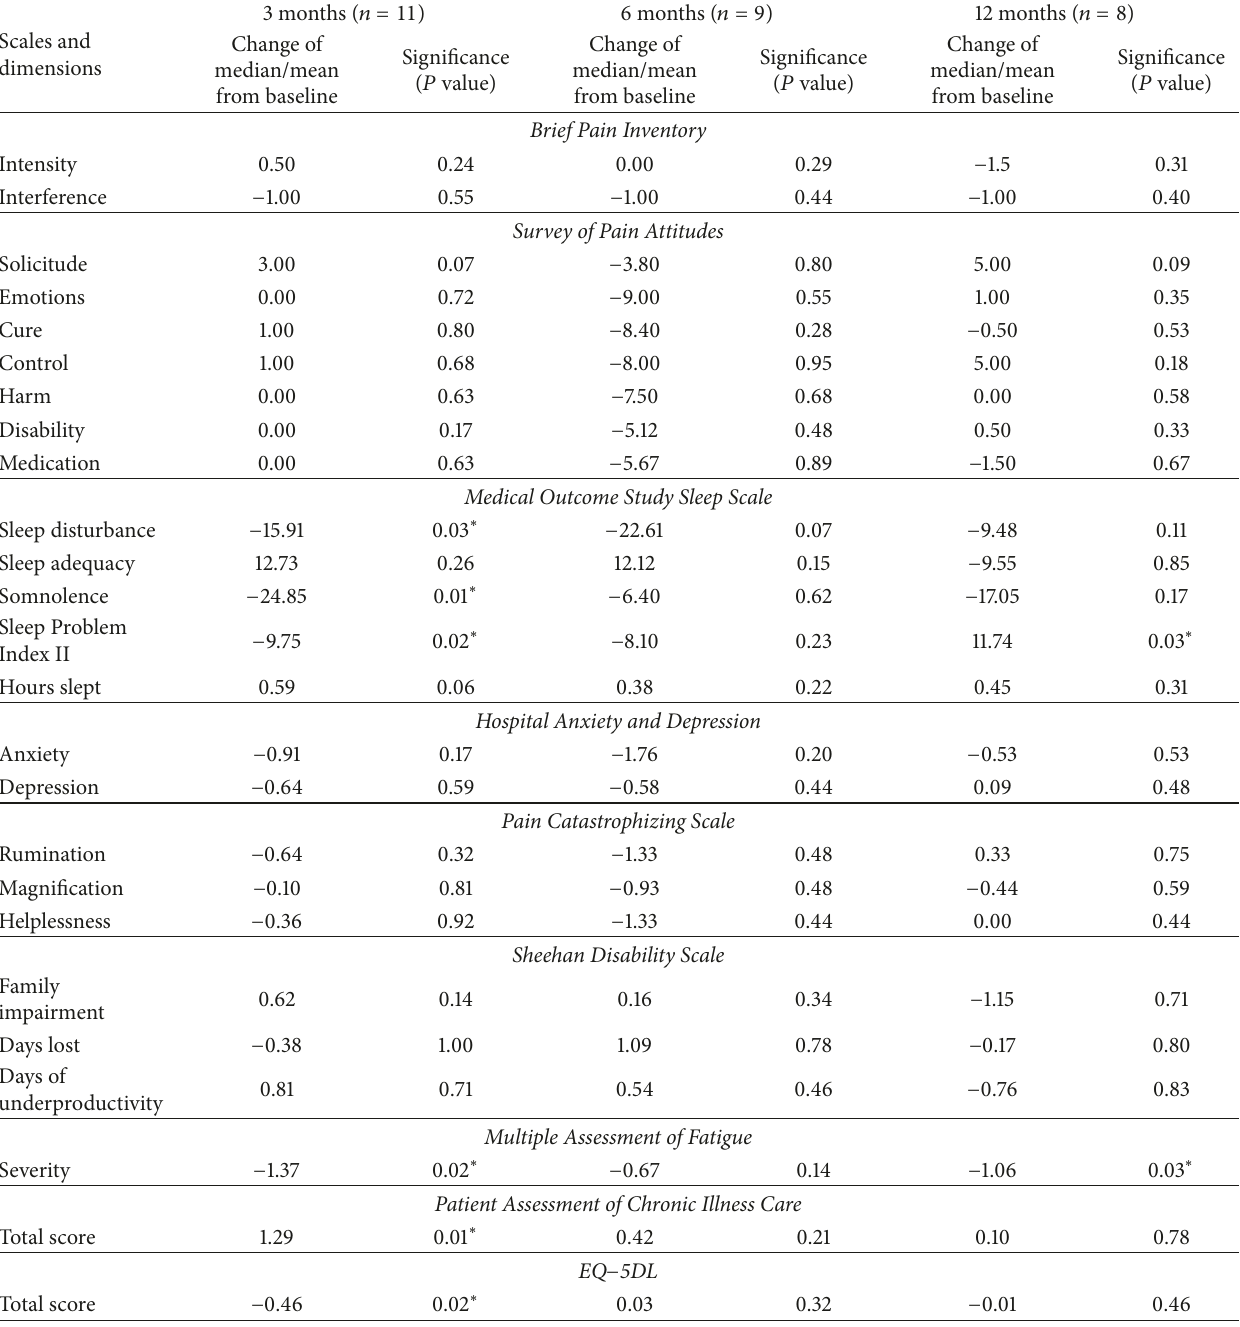
Table 4: Analysis of patient health